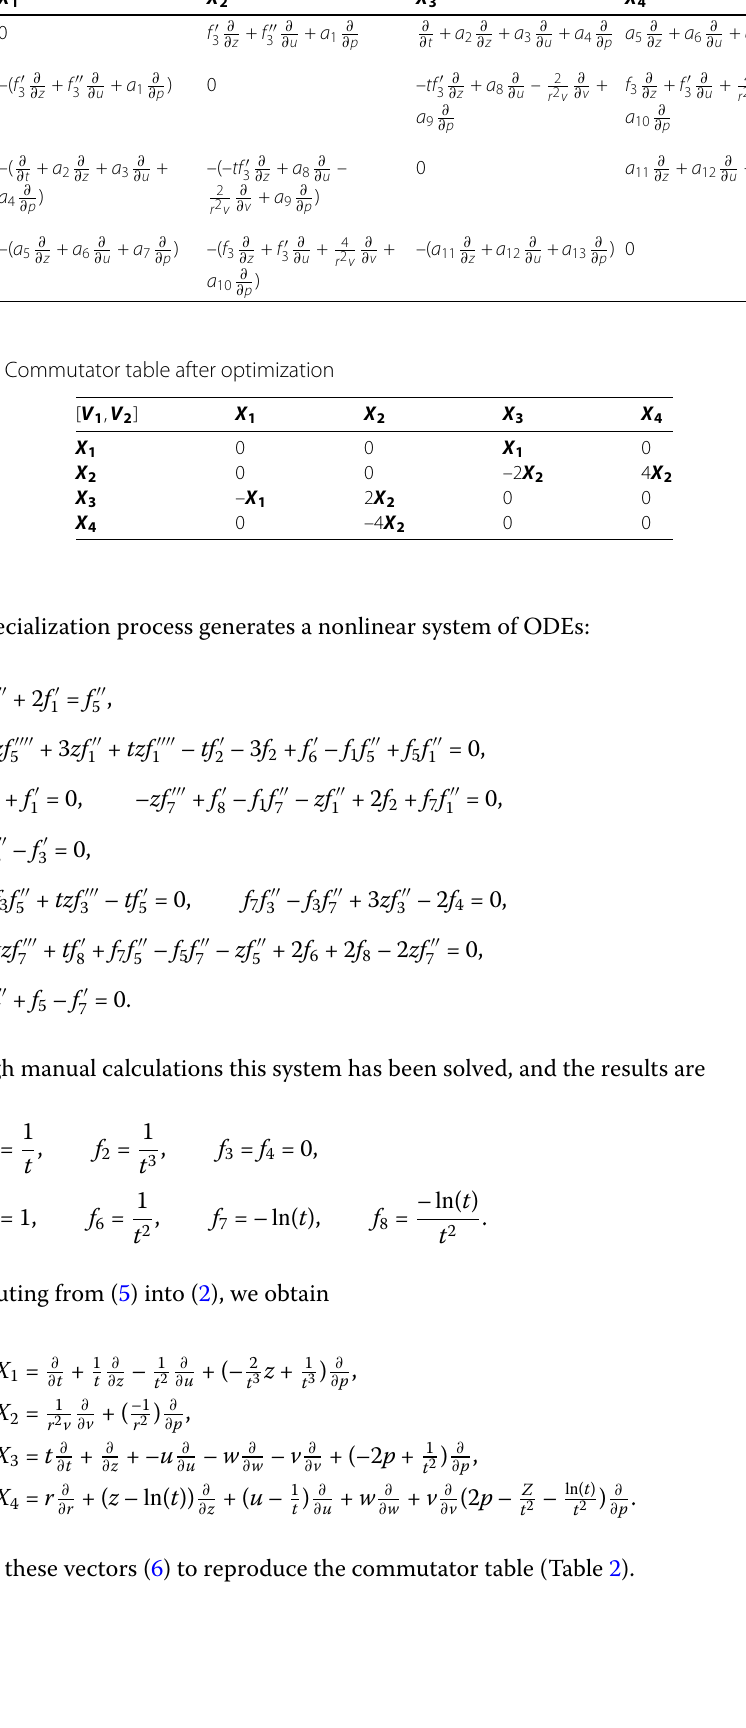
Table 1 Commutator table [ V 1 , V 2 ] X 1